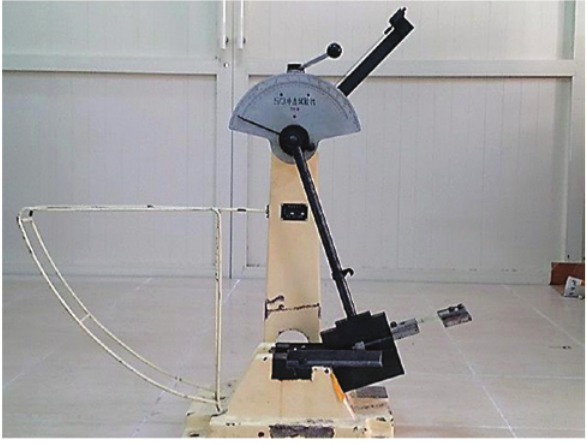
Figure 3: The Charpy impact tester with an axial impact adaptor.